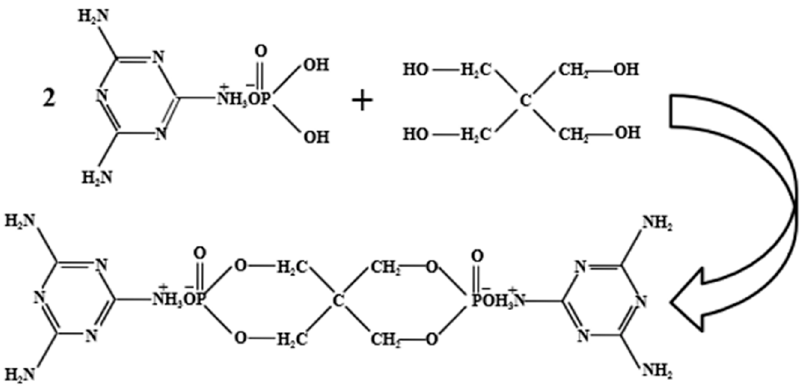
Scheme 1. The reaction route between PER and MP in extruding.